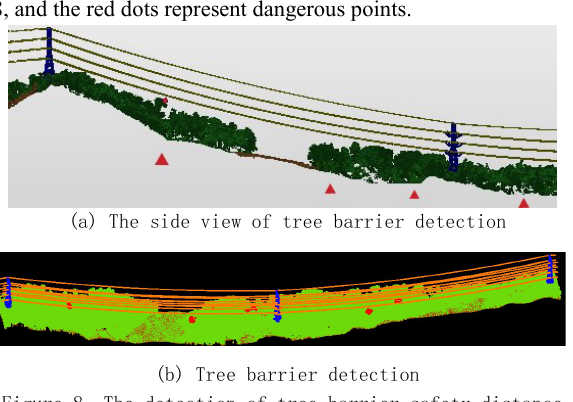
Figure 8. The detection of tree barrier safety